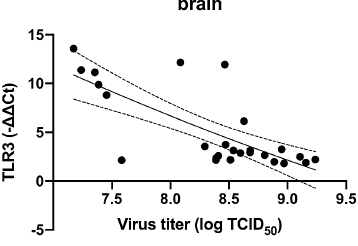
Figure 5. TLR3 expression plotted against virus titer for brain for all time points post challenge. Notably, as virus titers increase (along x-axis), TLR3 expression drops (dpc 7–17). Correlation between virus titer and TLR3 expression in brain for all time points post challenge, dotted line indicated 95%